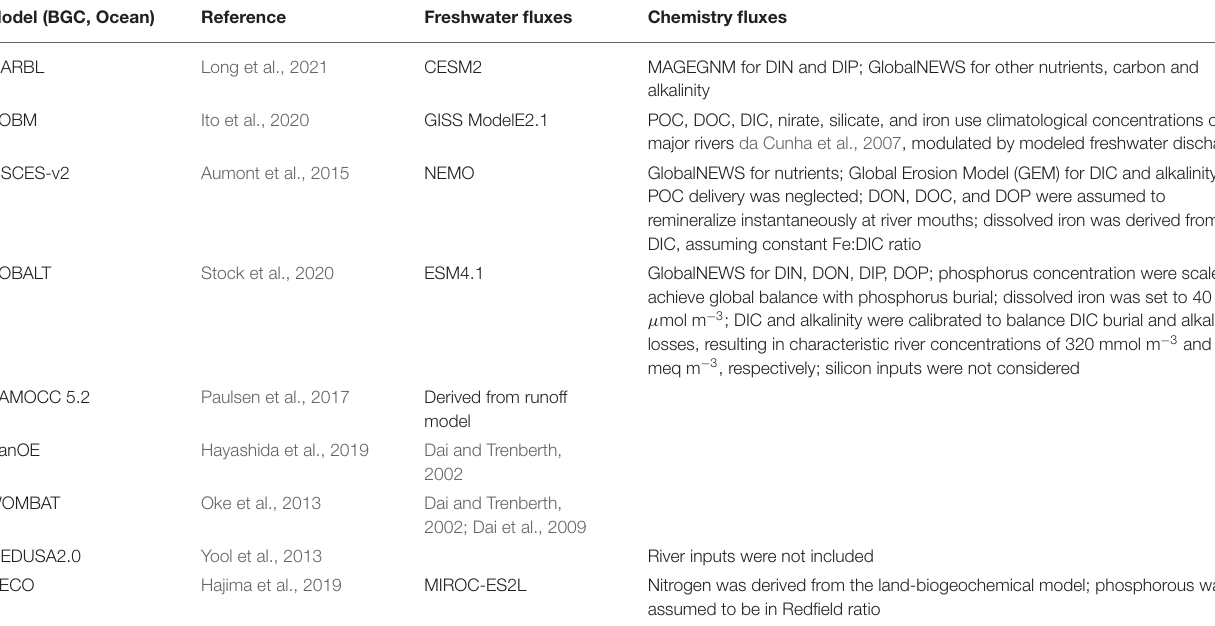
Note that we list the models by biogeochemical module for consistency with other tables in this study, even though river input forcing is simulation-specific rather than being an intrinsic part of the biogeochemcial model.